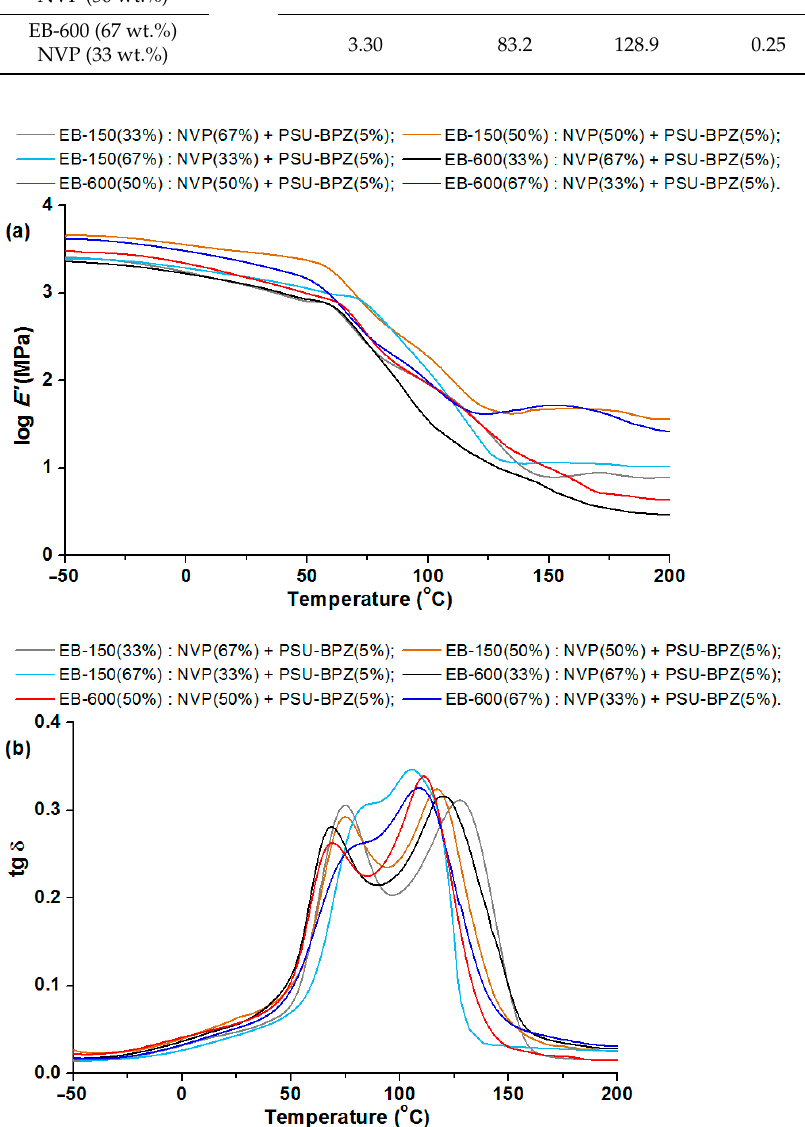
Figure 14. DMA analysis of polymeric blends with 5 wt.% of dopant: ( a ) storage modulus and ( b ) tangent delta in the function of temperature.